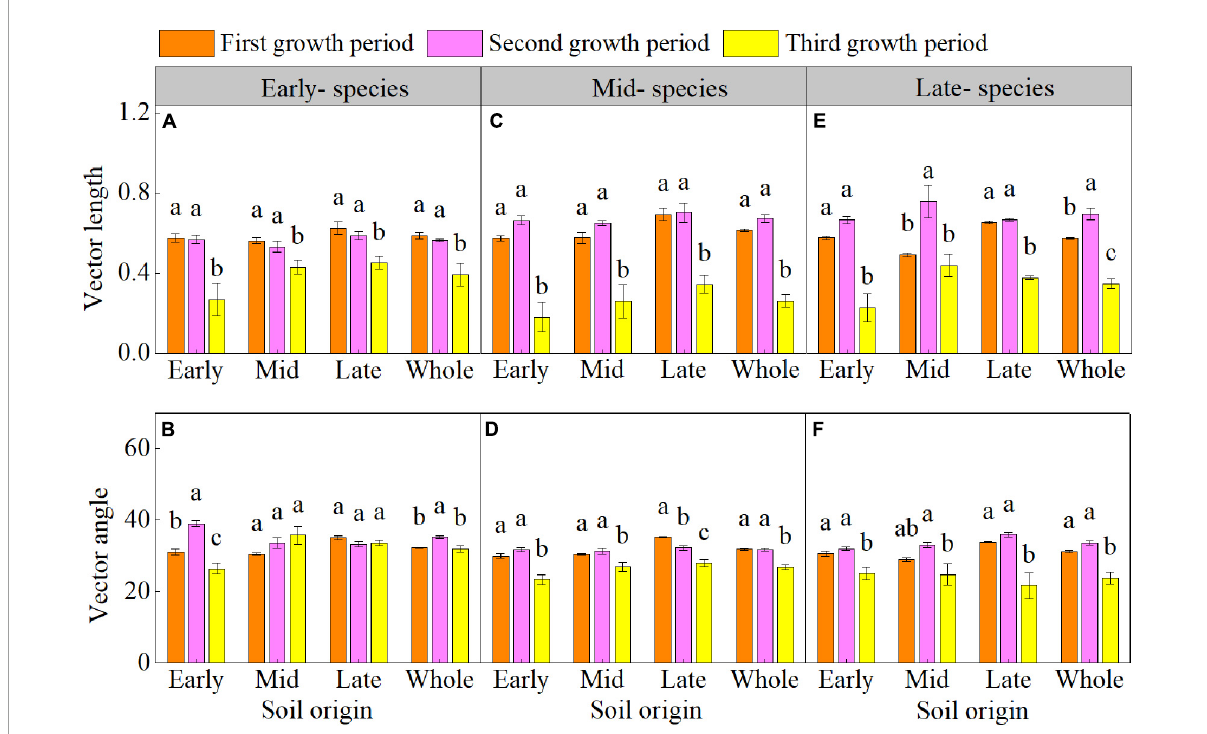
FIGURE4 Mean ( ± SE) ( n = 5) vector length and vector angle of early- (A,B) , mid- (C,D) , and late-species (E,F) over the three growth periods. “Whole” is the average vector length and vector angle of the same species in the three soils. Different lower letters indicate significant differences in mean vector length and vector angle among the three growth periods based on Duncan’s post-hoc test ( p <